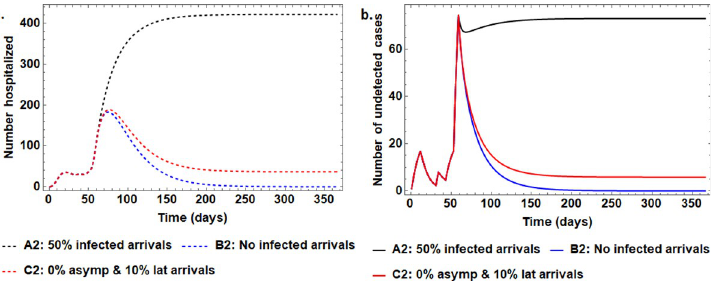
Fig 3. The effect of reducing the number of imported COVID-19 cases and latently infected individuals by 50% in Scenario A2, are completely eliminated in Scenario B2 and in Scenario C2 there are no asymptomatic infectious and there are only 10% latently infected individuals that are granted entry after 58 days post first case reporting in Uganda. These measures are implemented together with a partially lifted lockdown where 30% (instead of 10% that is assumed to be in place before the 58 days) of the population is susceptible. The different panels depict the time series variation for, Panel (a): the number of hospitalized individuals and Panel (b): the number of undetected infectious individuals that are freely living in the communities. In each scenario, all other parameter values at maintained at their default values.